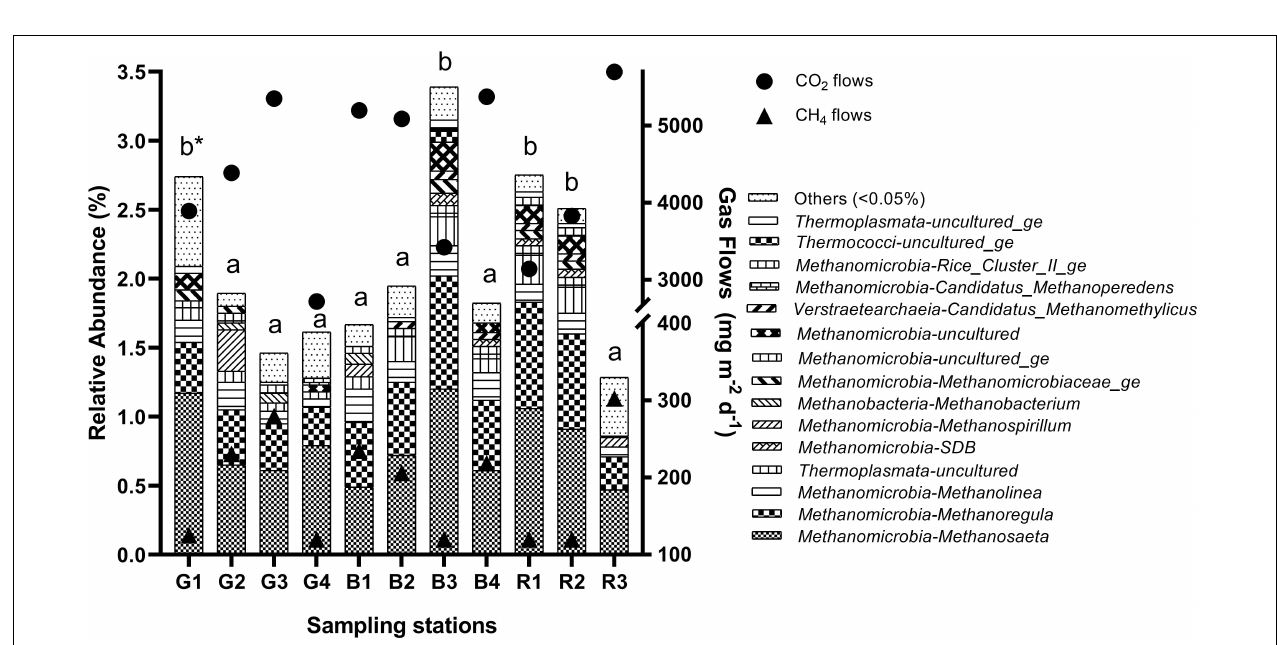
FIGURE 3 | Relative abundance of methanogenic archaea genera in the sediment of reservoirs and the atmospheric CO 2 and CH 4 flows throughout the sampling stations. “Others” refers to a group of genera with abundances lower than 0.05%. *Means with equal letters do not differ by the Scott–Knott test at 5% significance to methanogens